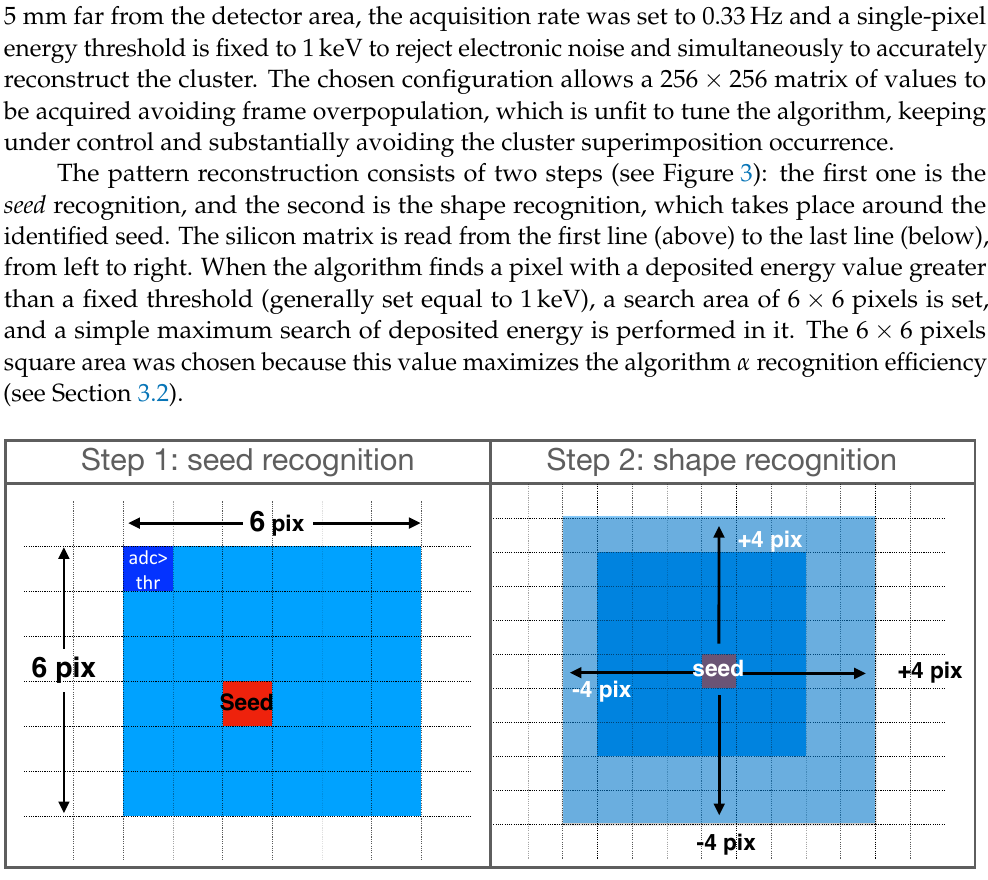
Figure 3. Pattern recognition algorithm sketch. The seed recognition part is shown in the left canvas. Once the deposited energy in a pixel is found to be above a certain threshold, a maximum search routine is implemented in a 6 × 6 area, in order to find the cluster seed. The shape recognition part, shown in the right canvas, starts from the recognized seed for a larger area, equal to 9 × 9 pixels. The deposited energy of each pixel in this area is summed up to calculate the cluster